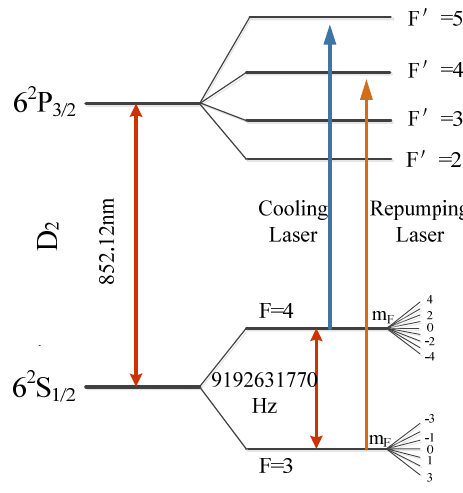
Figure 1. Hyperfine levels of 133 Cs.